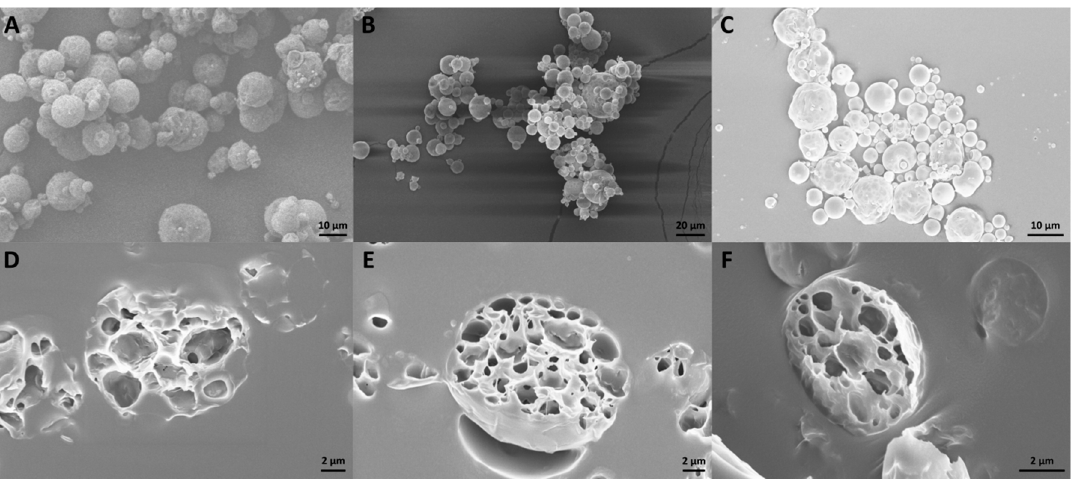
Figure 2. SME microscopy of microparticles (MPs)microstructure. ( A ) CUR–oil,( B ) CUR–water and ( C ) CUR–NE. In addition, their internal porosity was evaluated, depositing them on a PDMS layer 2 mm in thickness and cutting a PDMS block: ( D – F ) CUR–oil, CUR–water and CUR–NE, respectively.